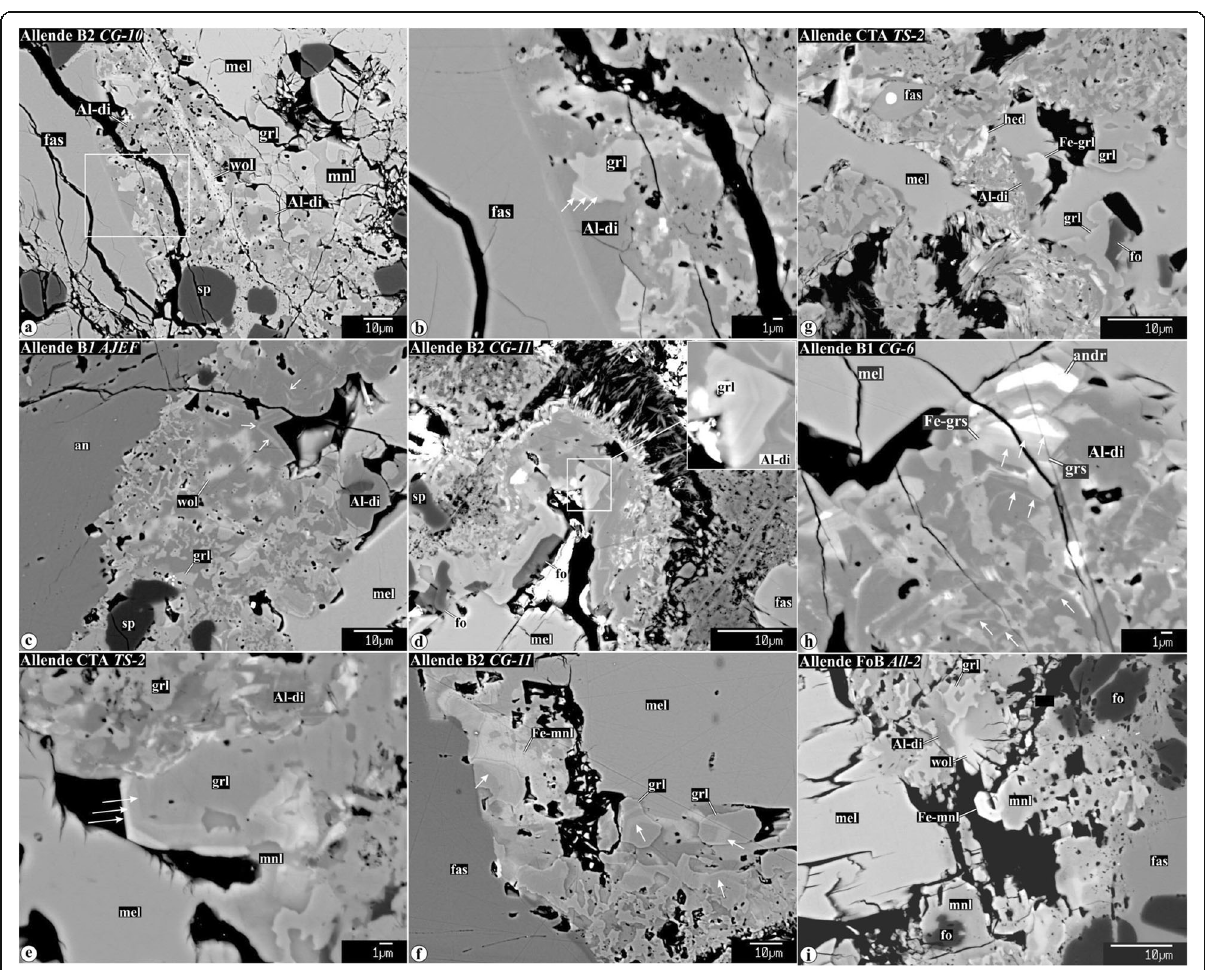
Fig. 10 Backscattered electron images of chemically zoned secondary minerals in the Allende coarse-grained CAIs. The oscillatory zoned grossular and Al-diopside are commonly observed in grossular-Al-diopside mineral assemblages and often contain FeO-rich secondary minerals: andradite, hedenbergite, ferroan monticellite, and ferroan